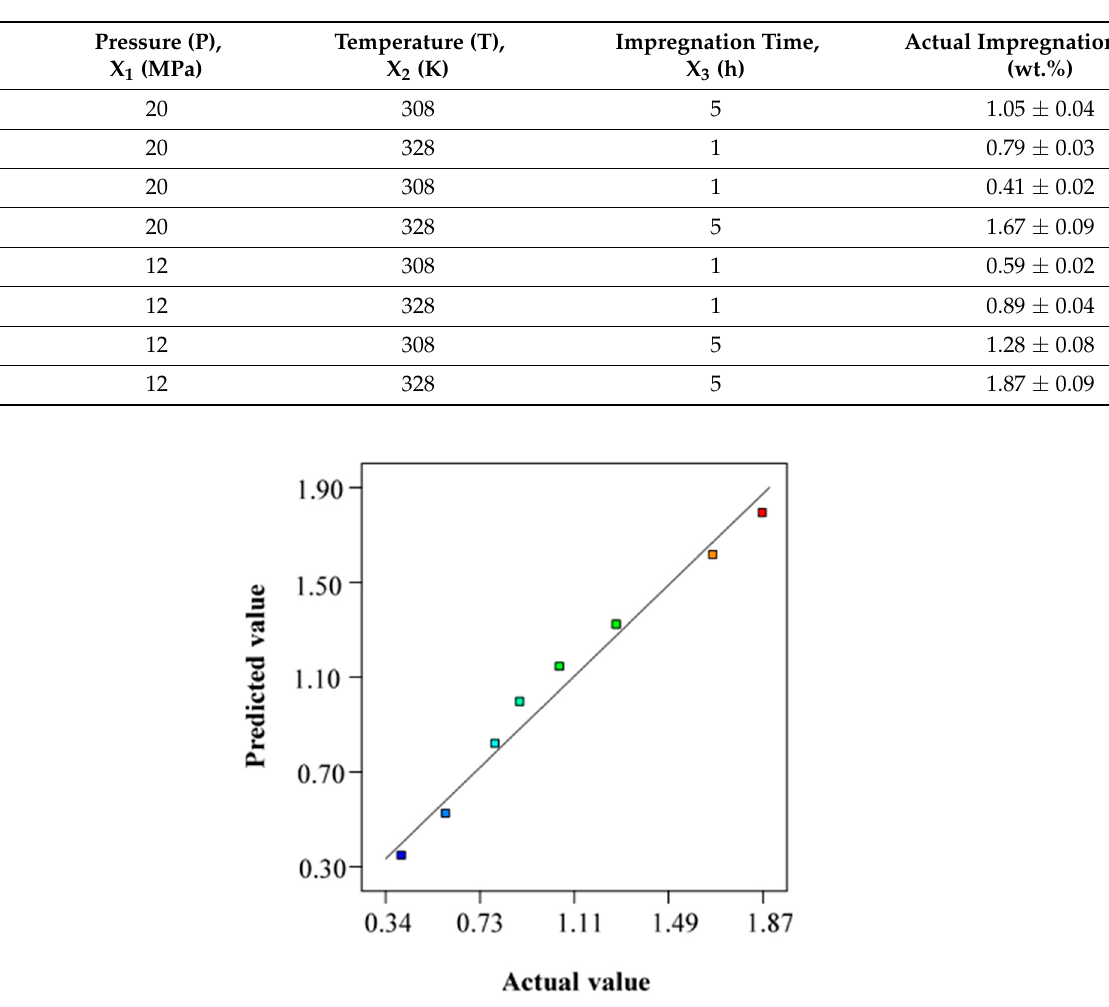
Table 4. The effect of impregnation parameters on impregnation yields of rosemary essential oil in LLDPE films.